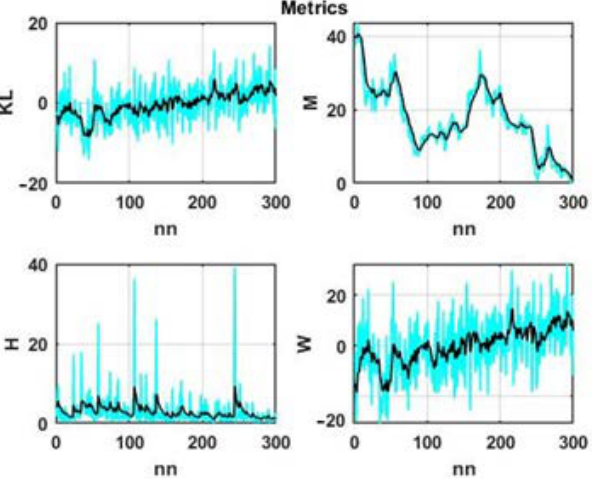
Figure 6. Smoothed changes in metrics for a multidimensional chaotic process.